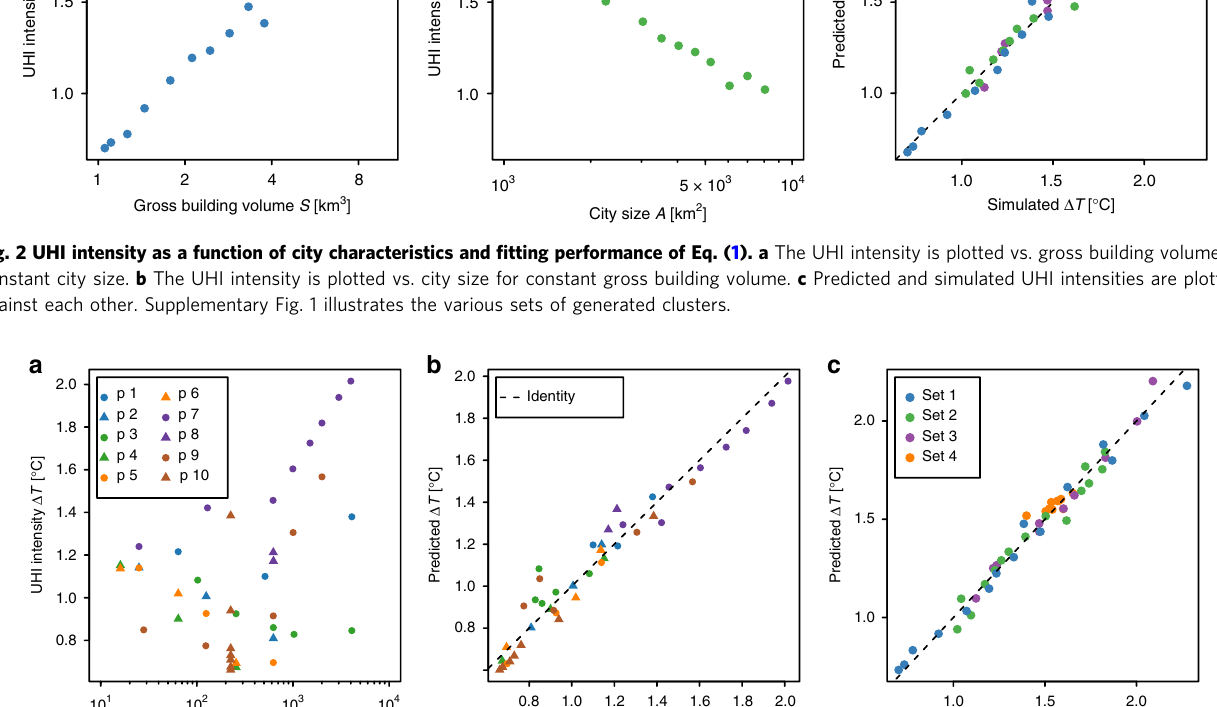
Fig. 3c, we again plot predicted and simulated values against each other, and fi nd similar agreement as in Fig. 2c, despite the more general approach. We would like to note that we also obtain ; w ; Y Þ (cid:3) ln f u i w i þ 1 decent fi tting if we employ f ð f i i u i Y i forms of power laws with small exponents and of the logarithmic function are quite similar. We fi nd that